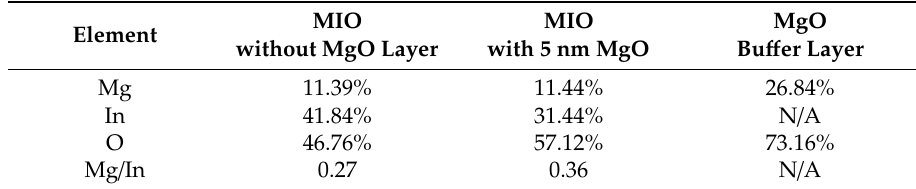
Table 1. Element composition (at.%) of MIO channel with and without the MgO bu ff er layer, and element composition of MgO bu ff er layer. N / A means we are only concerned about the amounts of Mg and O in the MgO